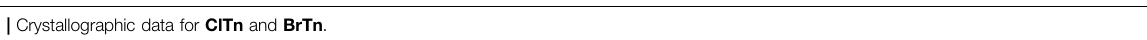
TABLE 1 | Crystallographic data for ClTn and BrTn .